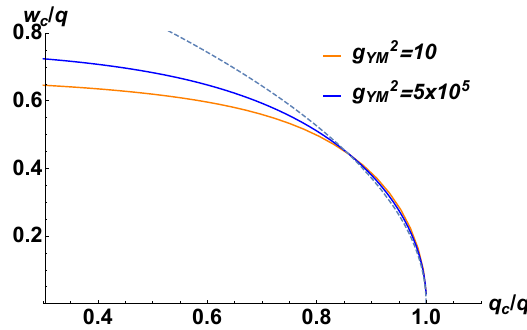
p 1 (cid:0) q c =q . The critical charge q c